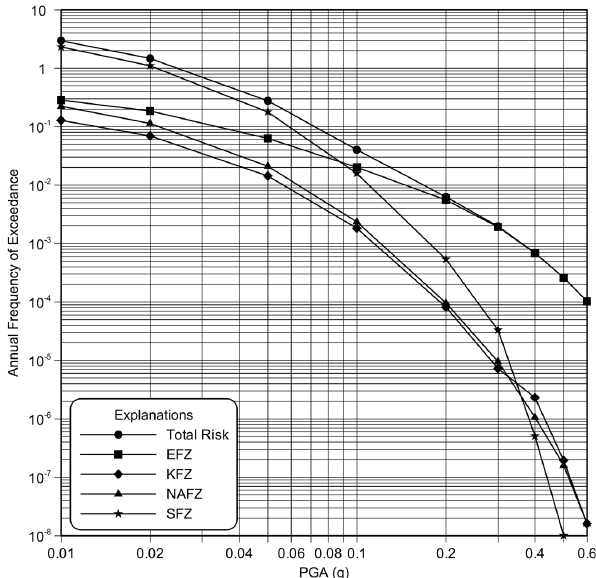
Fig. 8. Mean seismic hazard curves for the study